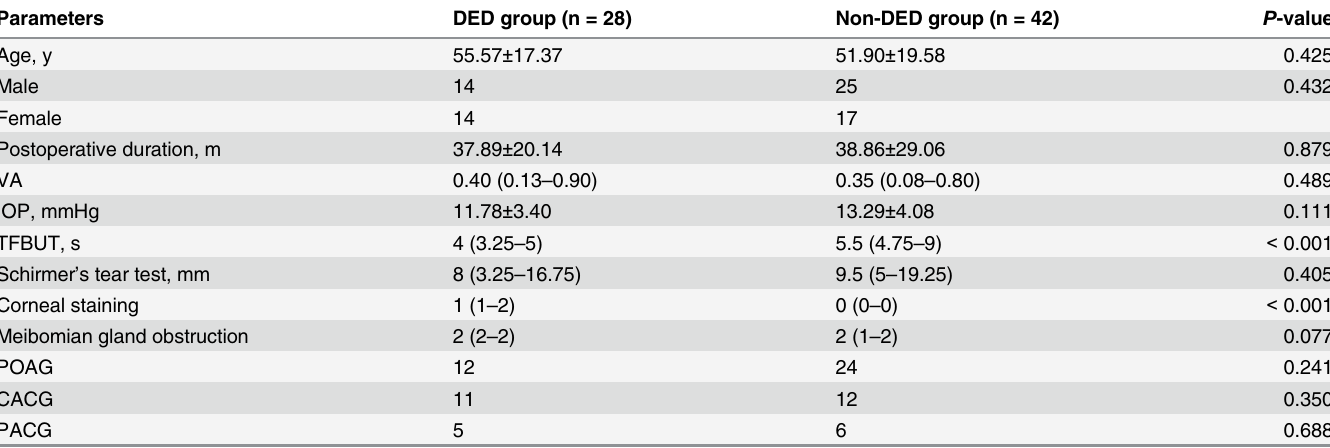
Table 5. Ocular surface parameters in the DED and non-DED groups. Parameters